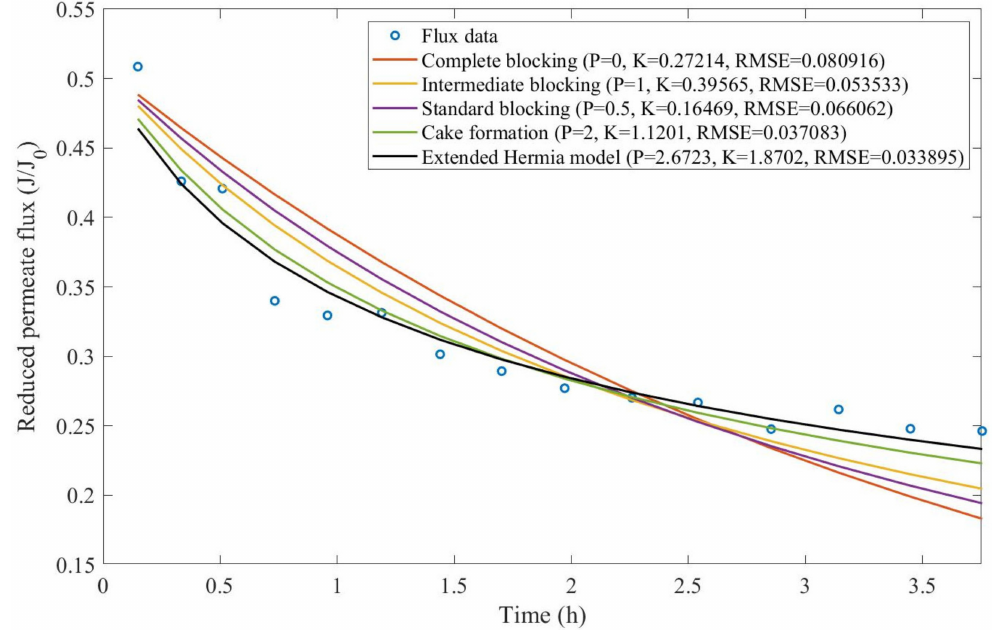
Figure A35. Model fitting for the third fouling stage of ultrafiltration of bovine serum albumin solution at 103.421 kPa considering the four original pore-blocking mechanisms and the extended Hermia model (Coated membrane)